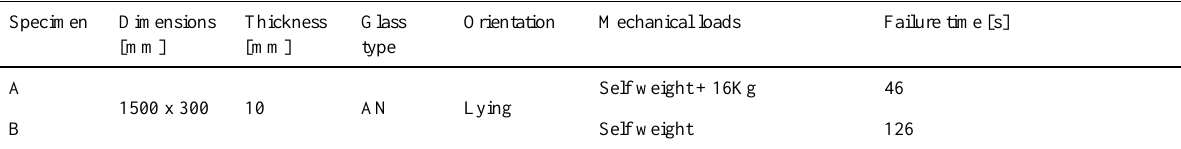
Table 1: Summary of selected past experiments (Nodehi,